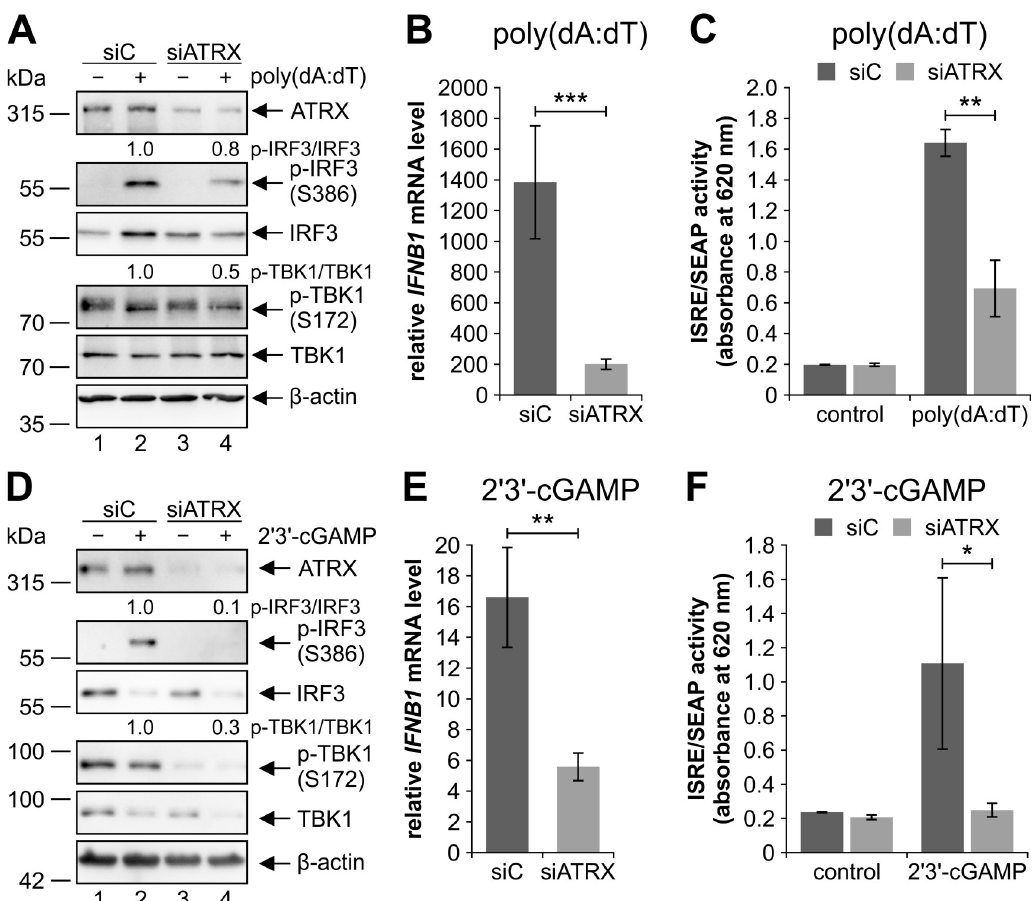
Fig 2. Repression of the cGAS-STING DNA sensing pathway in ATRX knockdown HFFs. ATRX knockdown HFFs (siATRX) and respective control cells (siC) were treated with (A-C) 0.1 μ g/ml poly(dA:dT) and (B+C) DMSO or (D-F) 50 μ g/ml 2’3’- cGAMP for 24 h. (A+D) Cells were harvested for Western blot analyses to determine the phosphorylation of IRF3 and TBK1; β - actin served as an internal loading control. Signal intensities were quantified relative to treated siC cells (lane 2). The following antibodies were used: anti-phospho-IRF3 (Ser386) (EPR2346), anti-IRF3 (D6I4C), anti-phospho-TBK1 (Ser172) (D52C2), anti- TBK1 (D1B4), anti- β -actin (AC-15); (A) anti-ATRX (39-f); (D) anti-ATRX (HPA001906). (B+E) Total RNAs were isolated and RT-qPCR was performed to determine IFNB1 induction. Depicted values were calculated from triplicates relative to untreated siC cells using GAPDH as a housekeeping gene and are shown as mean ± SD. One out of (B) three or (E) two independent experiments is shown. Statistical analysis was performed with respective Δ Cq-values using a student’s t -test (unpaired, two- tailed); �� p < 0.01, ��� p < 0.001. (C+F) Supernatants of stimulated cells were harvested and mixed with HEK-Blue IFN- α / β cells. Type I IFNs in the supernatants were quantitated by measuring SEAP activity produced by HEK-Blue IFN- α / β cells using QUANTI-Blue. Depicted values are derived from triplicates and are shown as mean ± SD. Statistical analysis was performed using a student’s t -test (unpaired, two-tailed); � p < 0.05, �� p <